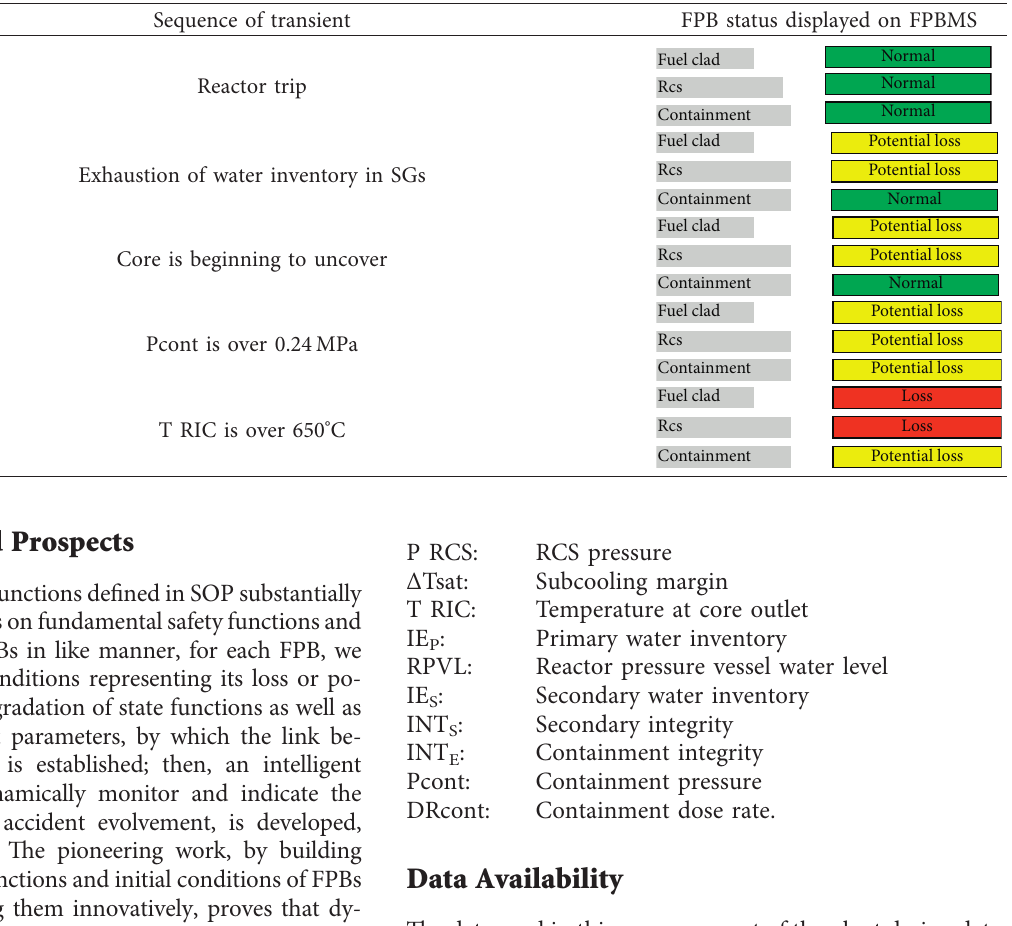
Table 2: Sequence and result of station